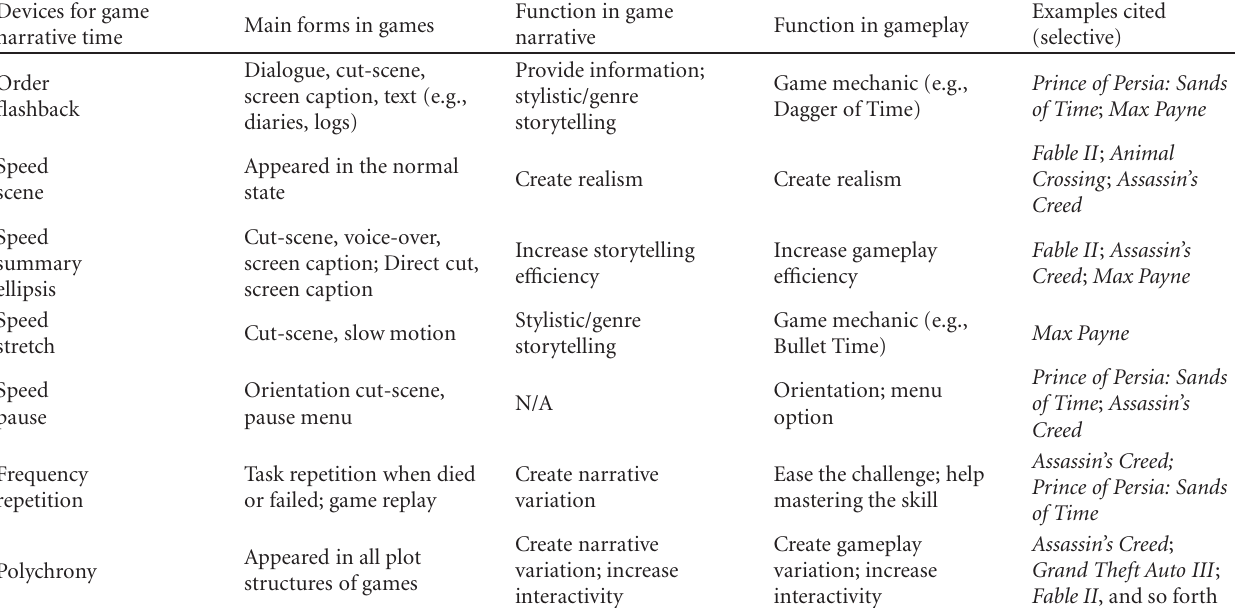
Table 1: Summary of temporal devices discussed that a ff ect narrative and gameplay experience.